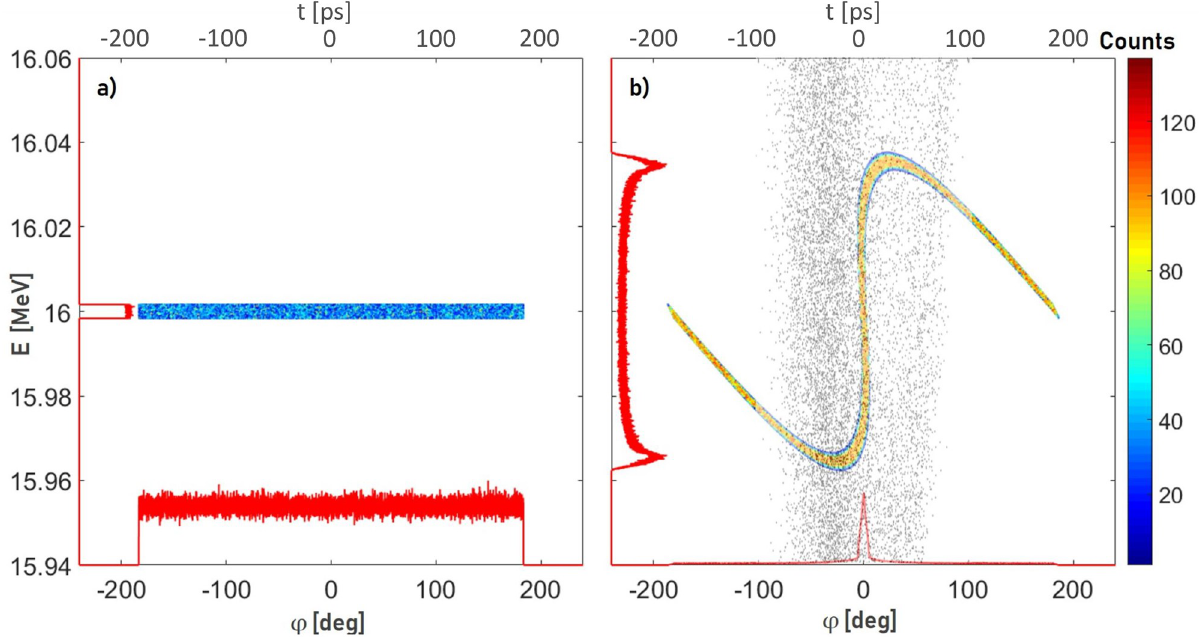
Fig 2. Longitudinal phase space between the tandem and linac. a) longitudinal phase space at z1 (see Fig 1) coming from the tandem ( E kin = 16 MeV, Δ E kin = 0.01%) [18] b) longitudinal phase space in front of the linac at z2 (see Fig 1) (colored dots) and accepted phase space of the linac (grey dots). The red curves along the x- and y-axes are projections of the particle distributions.